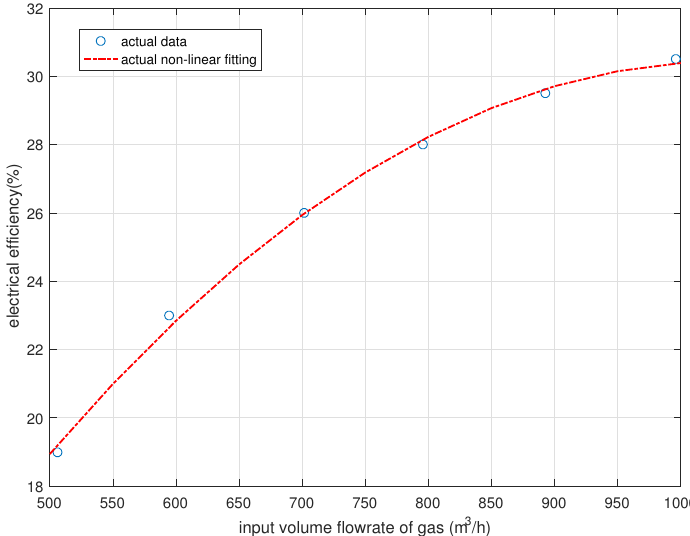
Figure 2. The efficiency curve of GT fitted by actual operating